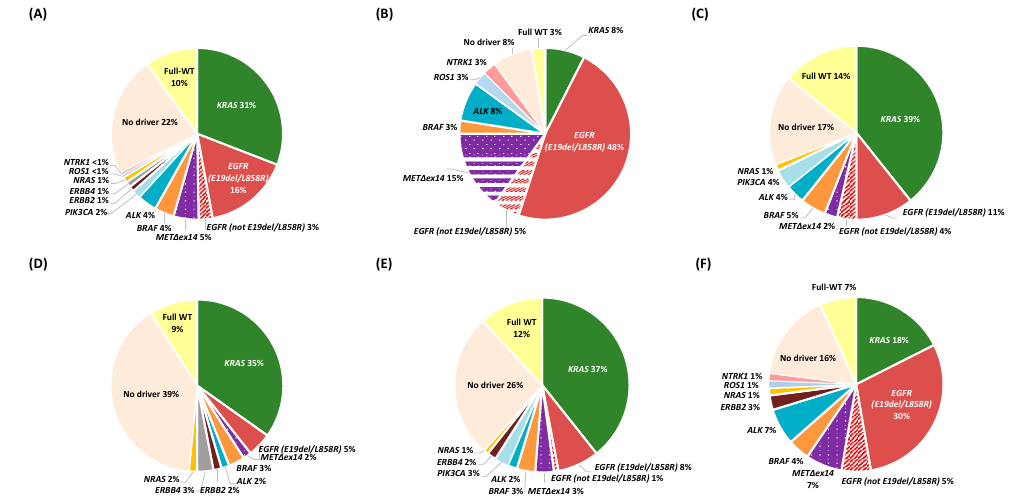
Figure 2. Genetic alterations identified. Pie charts depicting frequencies of driver alterations ( EGFR, BRAF, KRAS , MET ∆ ex14, ALK, ERBB2, ERBB4, PIK3CA, NTRK1, ROS1, and NRAS ) from 191 patients